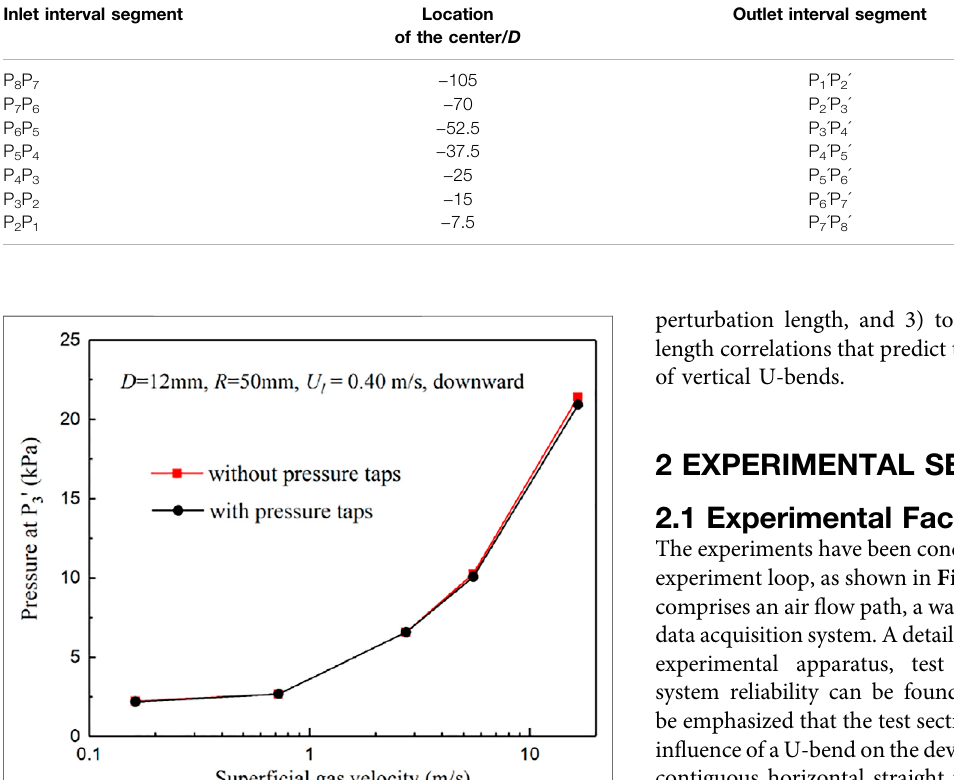
TABLE 1 | Distance between the center of each segmental measurement section to the bend ’ s inlet (A) or outlet (B). Inlet interval segment